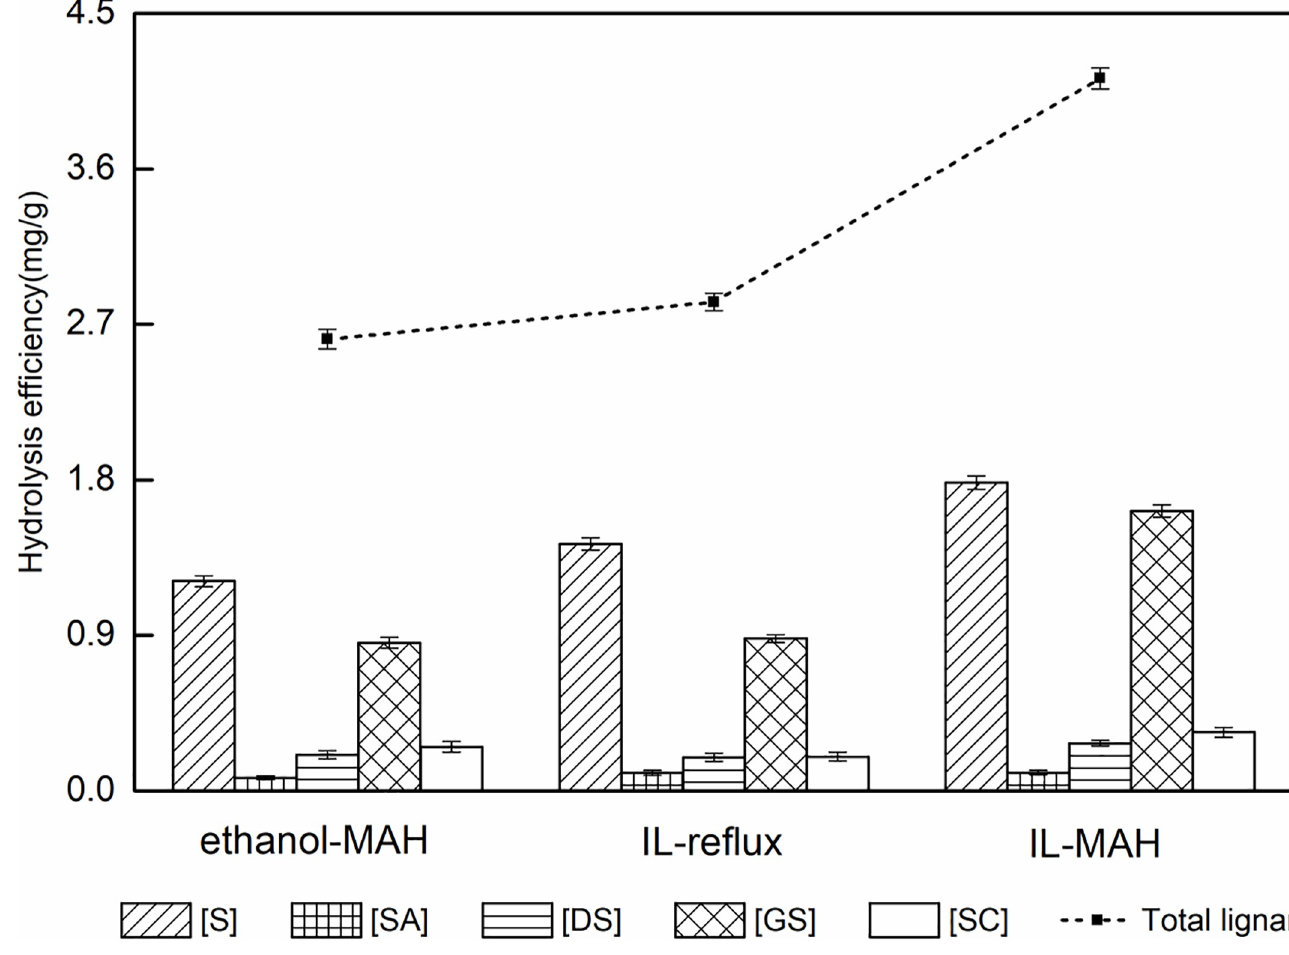
Fig 9. Yields of FBCL with different extraction